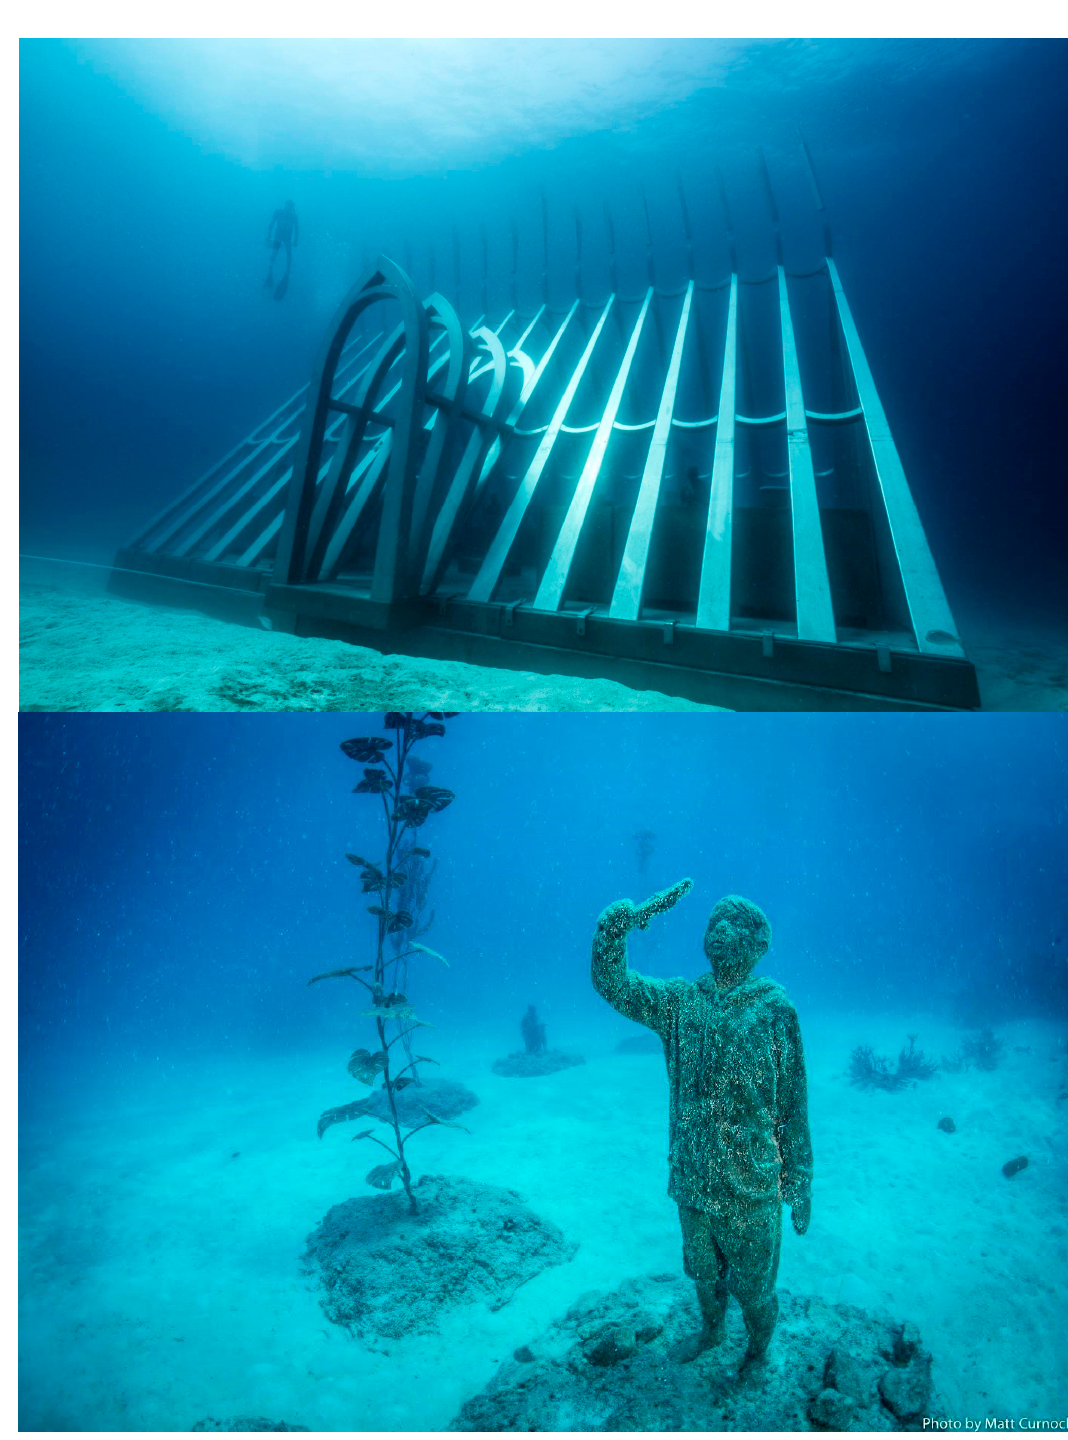
Figure 2. Coral Greenhouse sculpture at John Brewer Reef with a snorkeller in the background for scale. Photo credit Jason deCaires taylor ( Top ). Representative photo of individual sculptures of trees and people. Photo credit Matt Curnock ( Bottom ).